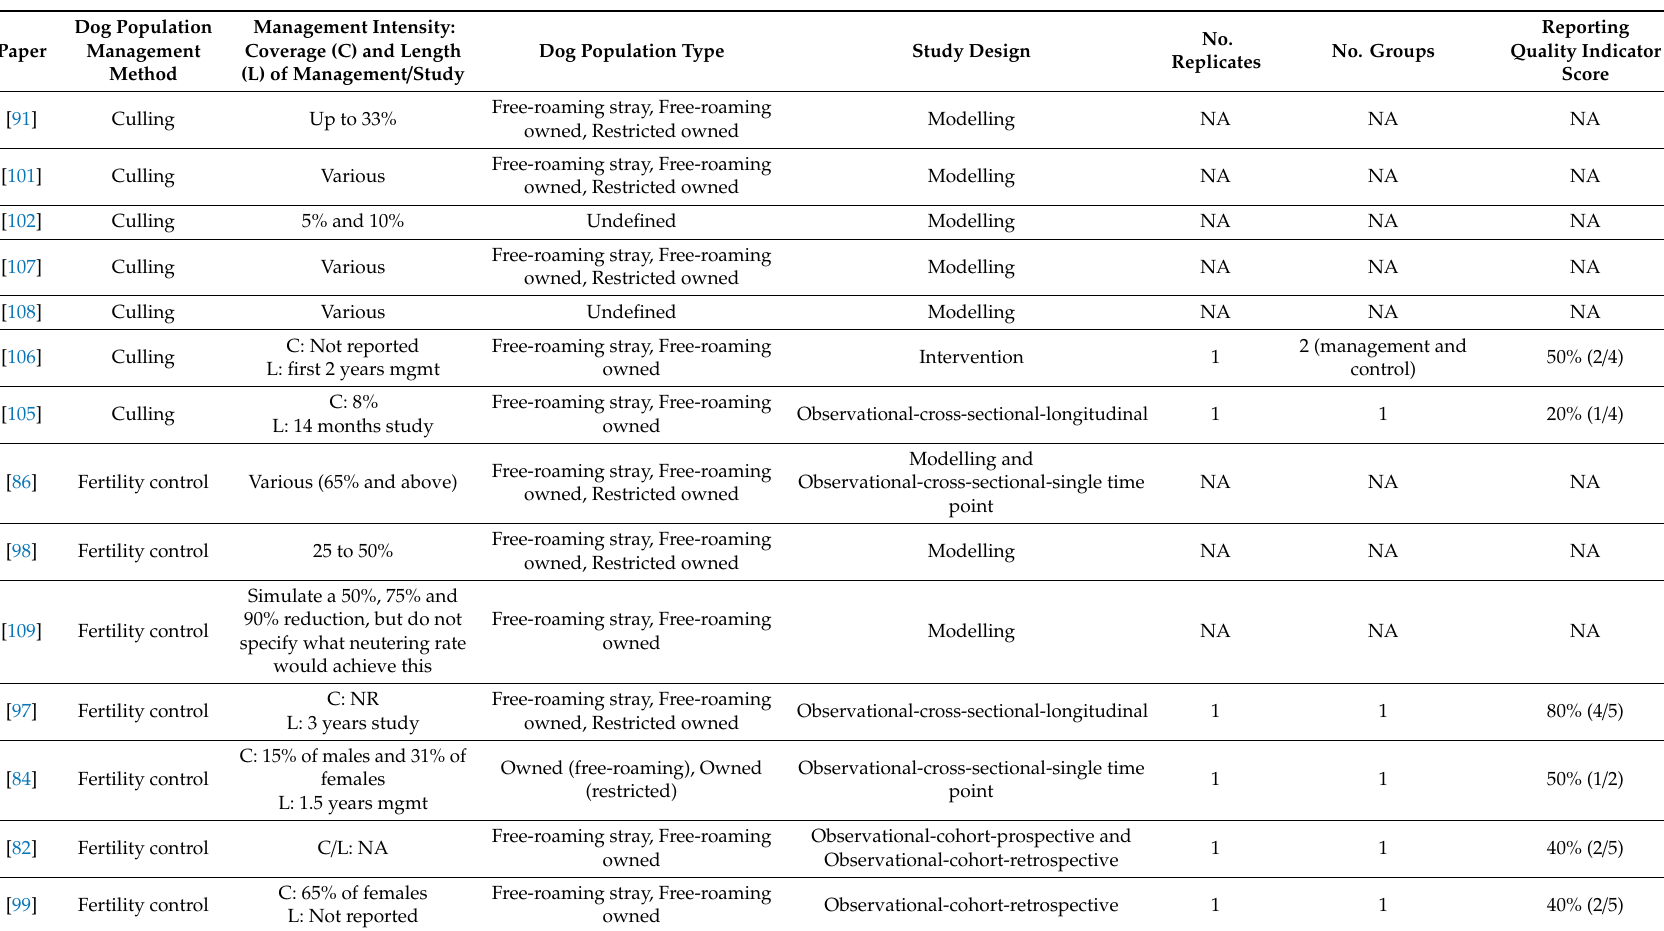
Table 2. All final corpus papers by management factors (method and intensity), study design factors, and reporting quality. Management intensity is reported in terms of coverage and length. Length is reported as years of: (i) mgmt. = management (indicating the study and management method took place at the same time) or (ii) study (indicating the study took place after management began). NA = not applicable for the study